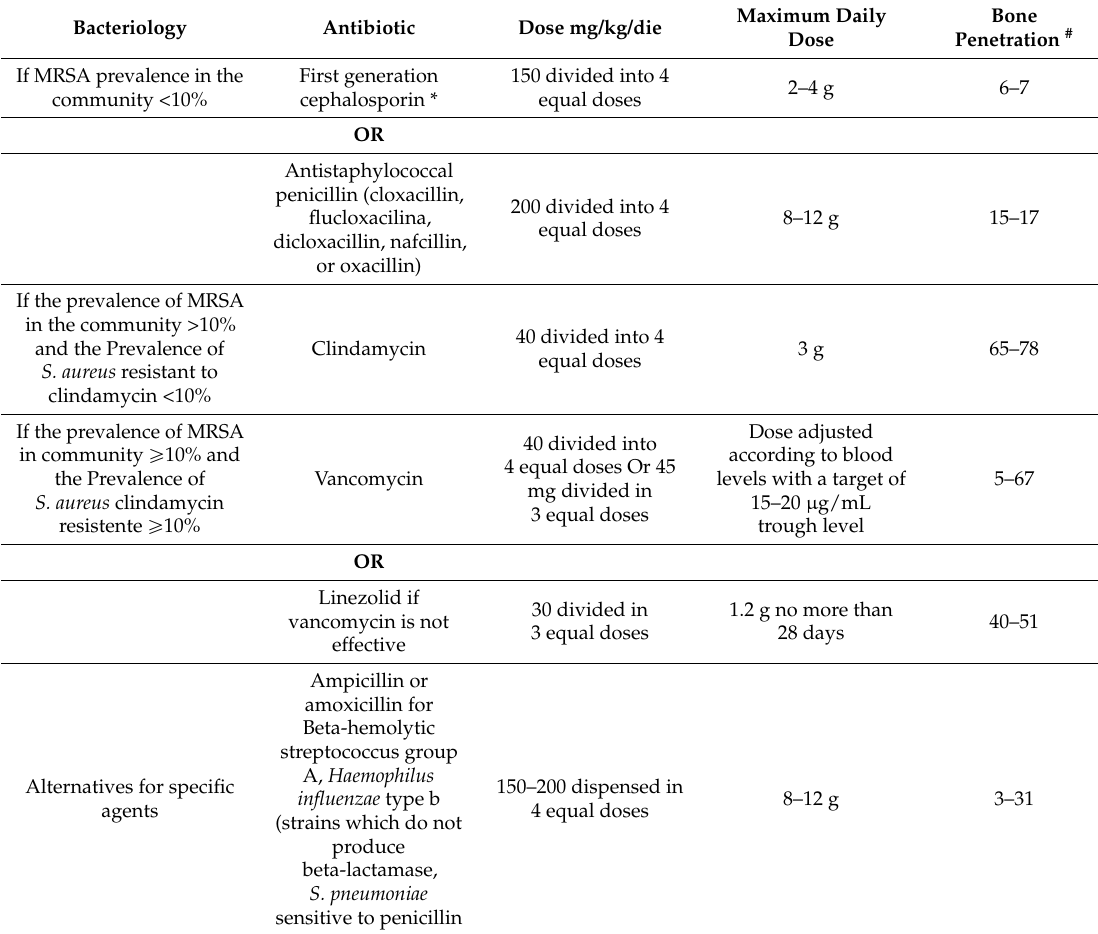
Table 4. Proposed antibiotic treatment for acute osteomyelitis in children